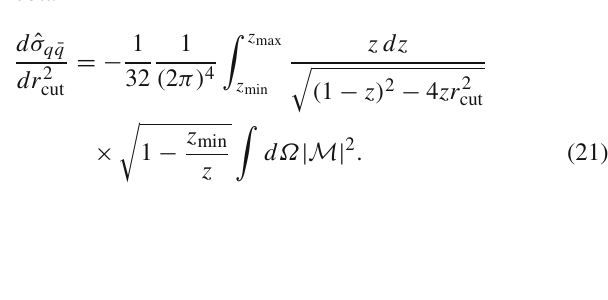
Fig. 3 NLO EW correction as a function of r cut in the dominant qq diagonal channel (left panel) and in the off-diagonal q ( ¯ q )γ channel (right panel) at 14TeV. The NLO result is normalised to the r cut - and z = M 2 / s